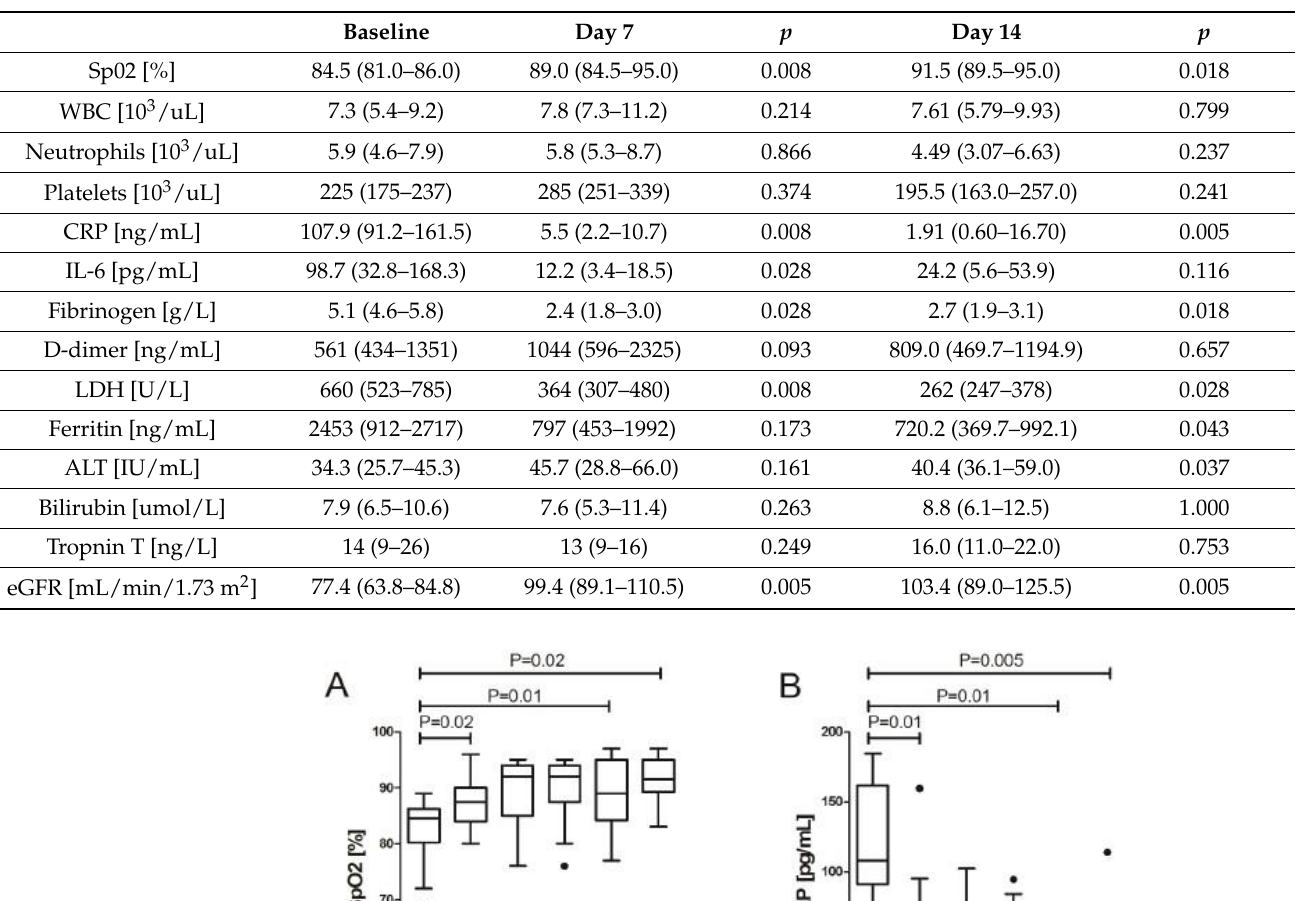
Table 3. Dynamics of serum proinflammatory markers and safety parameters in subjects treated with low-dose radiation therapy for severe COVID-19 (median, IQR, P statistical significance baseline vs. day 7 and day 14).